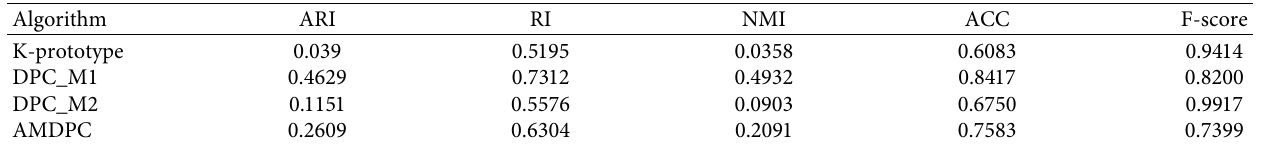
Table 7: Clustering results of Acute dataset.